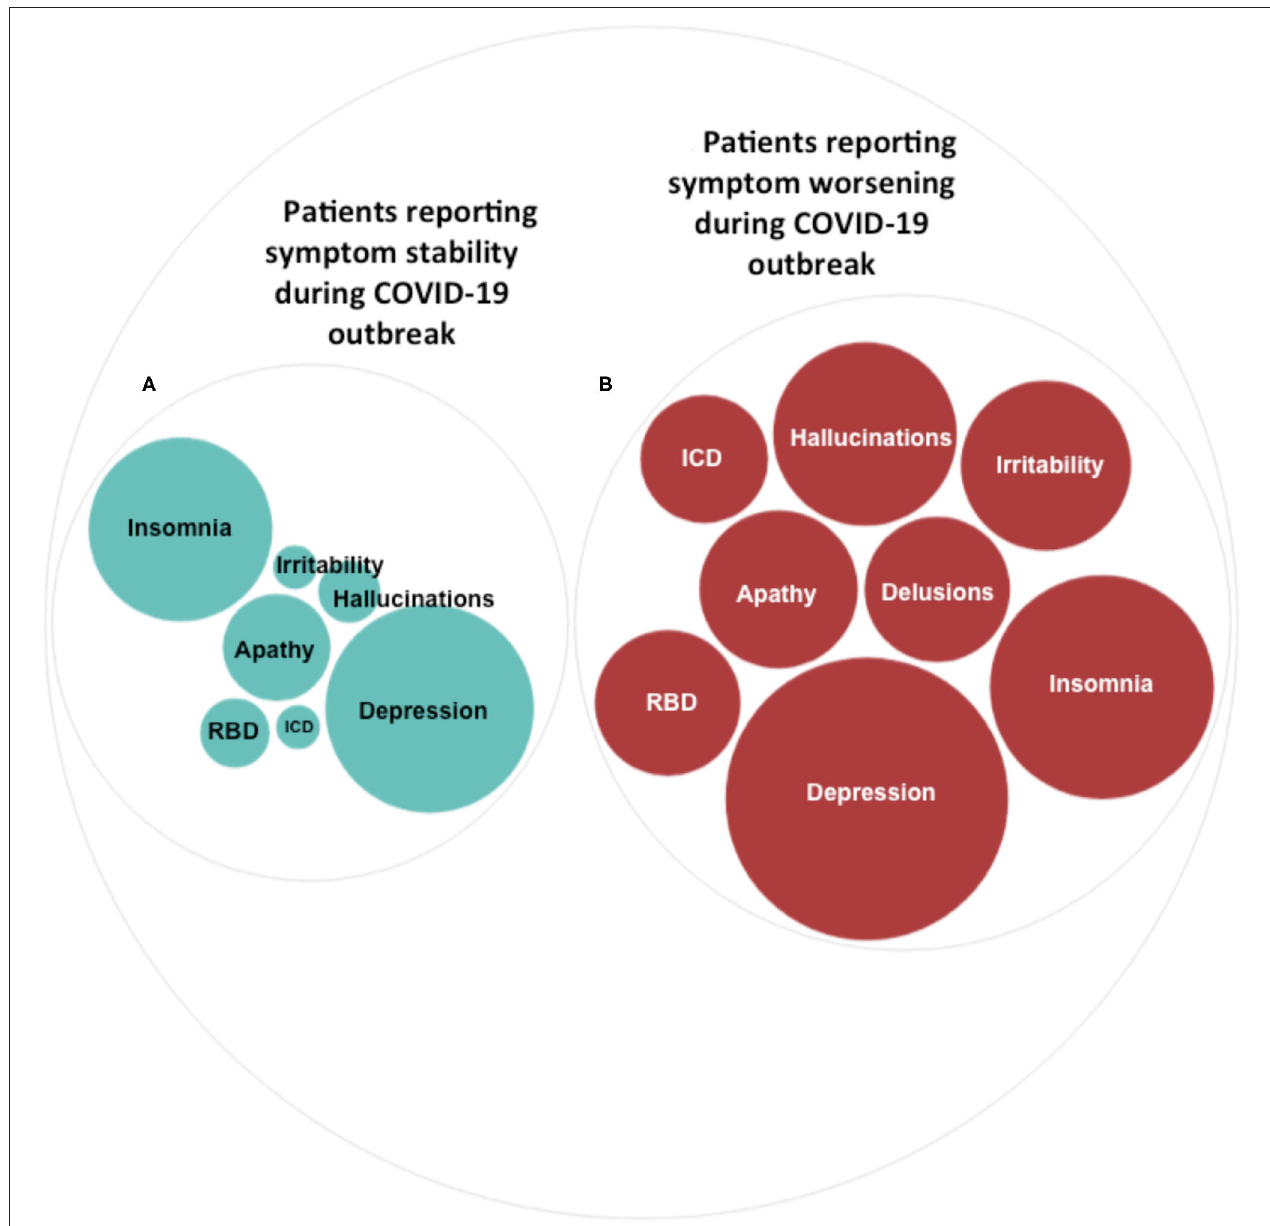
FIGURE 1 | Psychiatric symptoms during the COVID-19 outbreak. Prevalence of different types of psychiatric symptoms in patients reporting symptom stability (A) and in patients reporting symptom worsening (B) during the COVID-19 outbreak. The size of the circles indicates the percentages (%) of individuals in each group reporting specific psychiatric symptoms. Percentages are detailed in Table 1